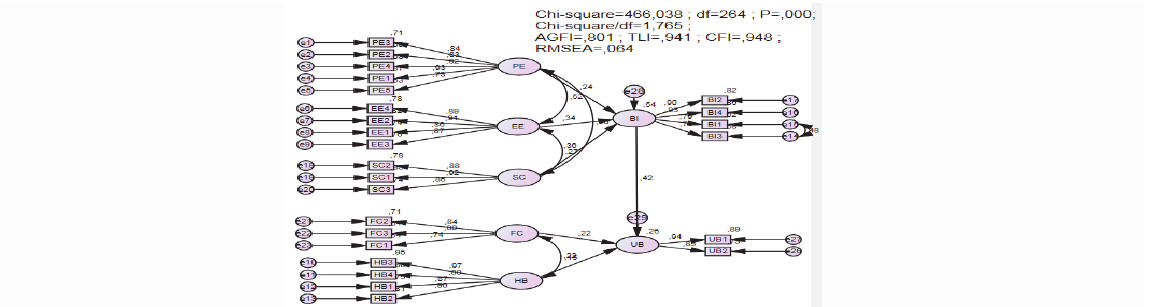
Fig. 3. The final results of analyzing by SEM model (standardized)